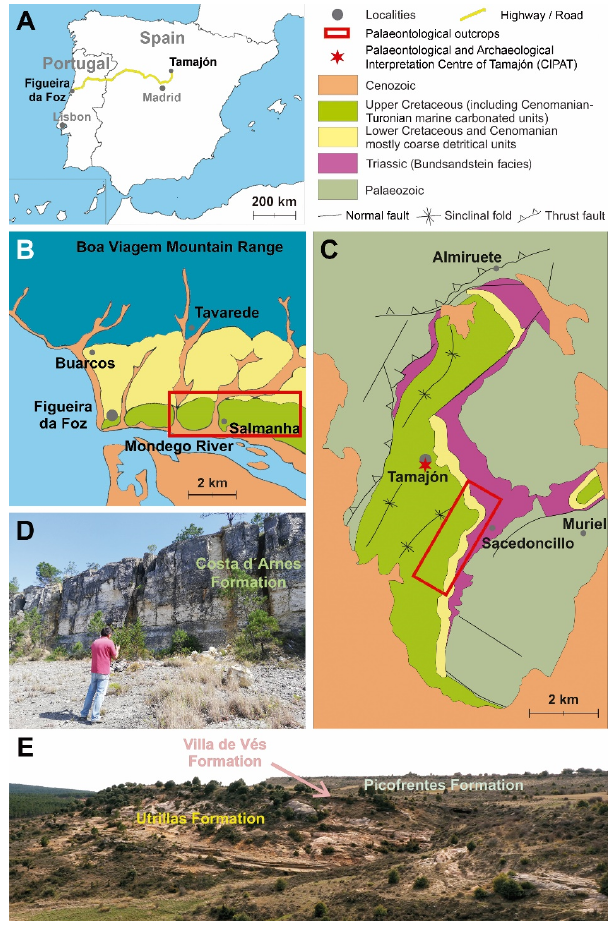
Figure 1. Geographical and geological context of the palaeontological sites of Figueira da Foz (Portugal) and Tamajón (Spain). ( A ) Map of the Iberian Peninsula locating the palaeontological sites of Figueira da Foz (Portugal) and Tamajón (Spain). ( B ) Geological sketch map of Figueira da Foz (Portugal). ( C ) Geological sketch map of Tamajón (Spain). ( D ) Photograph of the palaeontological site of Figueira da Foz showing the Costa d’Arnes Formation. ( E ) Photograph of the outcrops of Tamajón showing the Utrillas, Villa de Vés, and Picofrentes formations. Modified from [9].